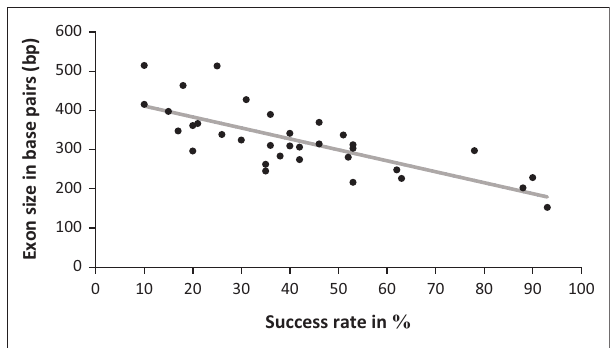
FIGURE 1: Effect of amplicon size on PCR amplification success rate of DNA extracted from FFPE tissue samples, Pretoria, South Africa, June 2015 – May 2016 (online Supplementary Document Table